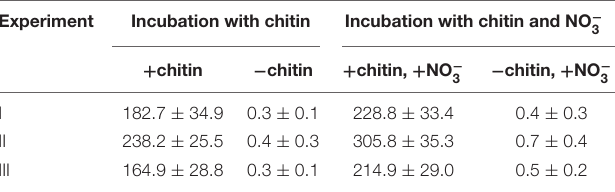
TABLE 4 | Cell numbers of SBC82 T determined by whole-cell hybridizations with Cy3-labeled probe HoAc1402 after 20 days of incubation with chitin as a source of carbon and nitrogen or as a source of